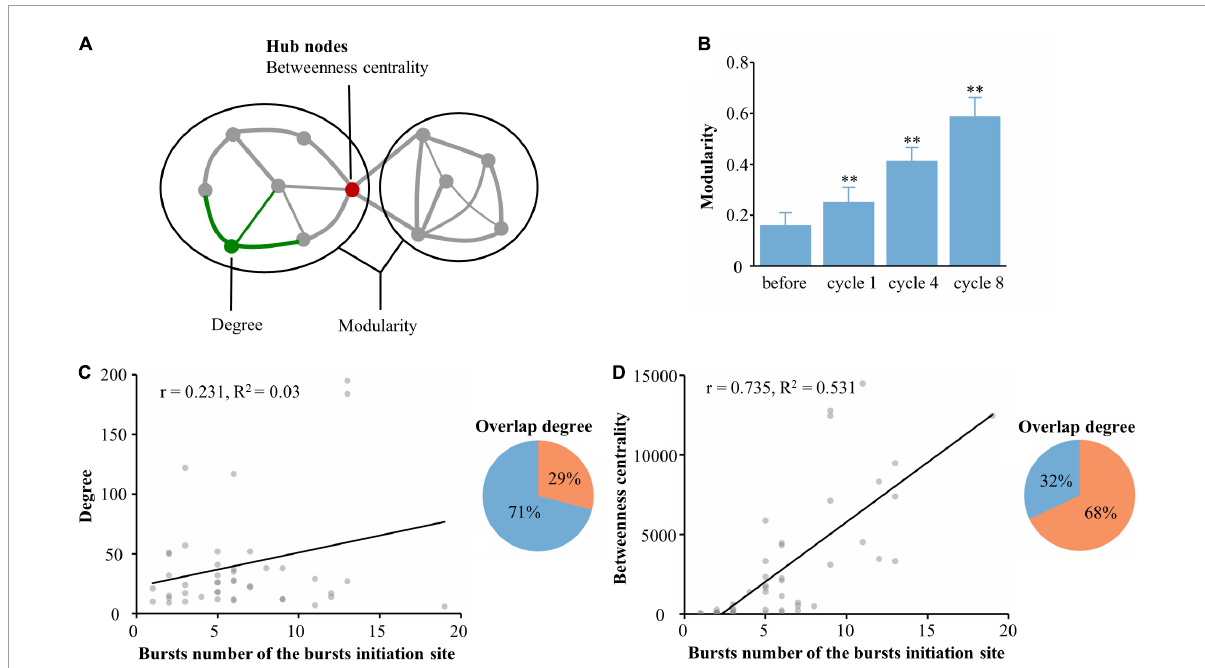
FIGURE5 Generation of spontaneous network bursts in the functional learning populations. (A) An artificial network example, where degree represents the number of links connected to a node (green) or module (ovals). Hubs (red) often occur along the shortest paths and consequently often have a high betweenness centrality. (B) The network modularity was compared throughout the experiment during spontaneous activities. (C) Linear regression of the number of bursts at burst onset and the average degree of the learning populations within 115 µ m of the burst onset (left). The overlap between neurons involved in the burst onset and those in the learning population with the top 90% modularity is shown in the right pie chart as orange. (D) Linear regression of the number of bursts at burst onset and the average betweenness centrality of learning populations within 115 µ m of the burst onset (left). The overlap between neurons involved in the burst onset and those in the learning population with the top 90% betweenness centrality is shown in the right pie chart in orange ( n = 5 cultures, time: 5 min, n = 284 bursts. ∗ p < 0.05 vs. before, ∗∗ p < 0.01 vs.